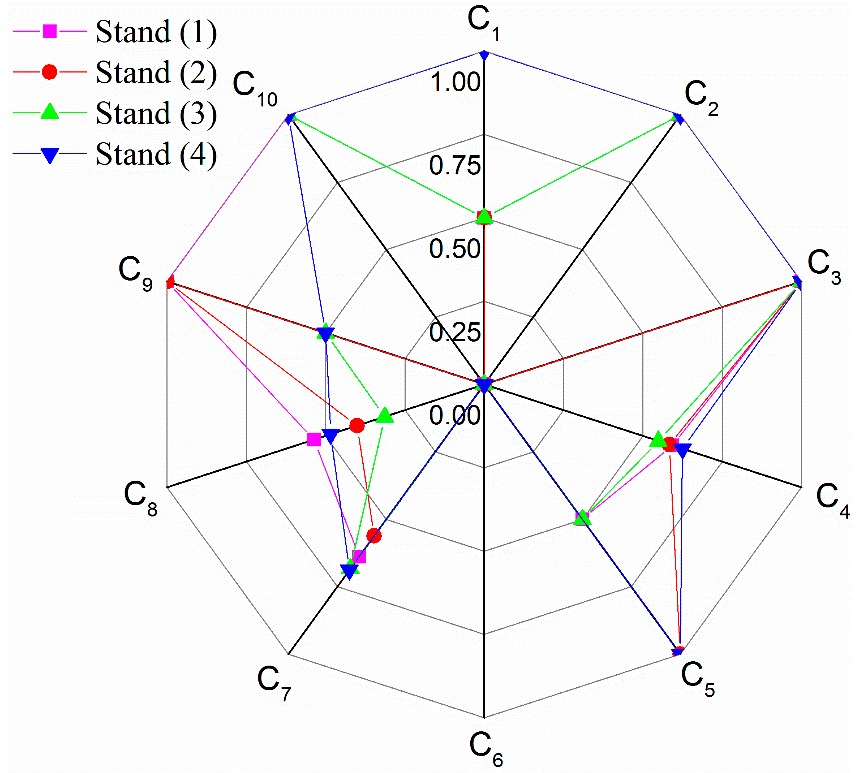
Figure 5. Radar plot of Q. aliena var. acuteserrata broad-leaved mixed forest (stands (1) and (2)) and P. koraiensis broad-leaved mixed forest (stands (3) and (4)).